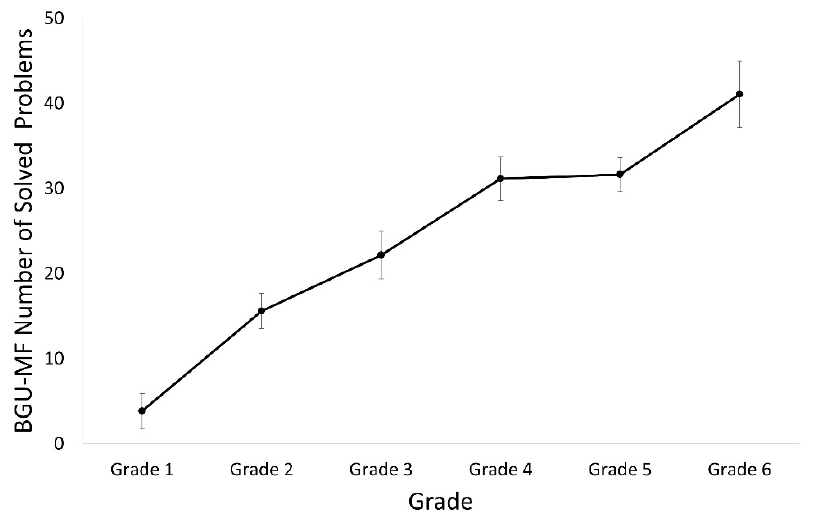
Figure 7. Number of solved problems in the BGU ‐ MF for each grade.